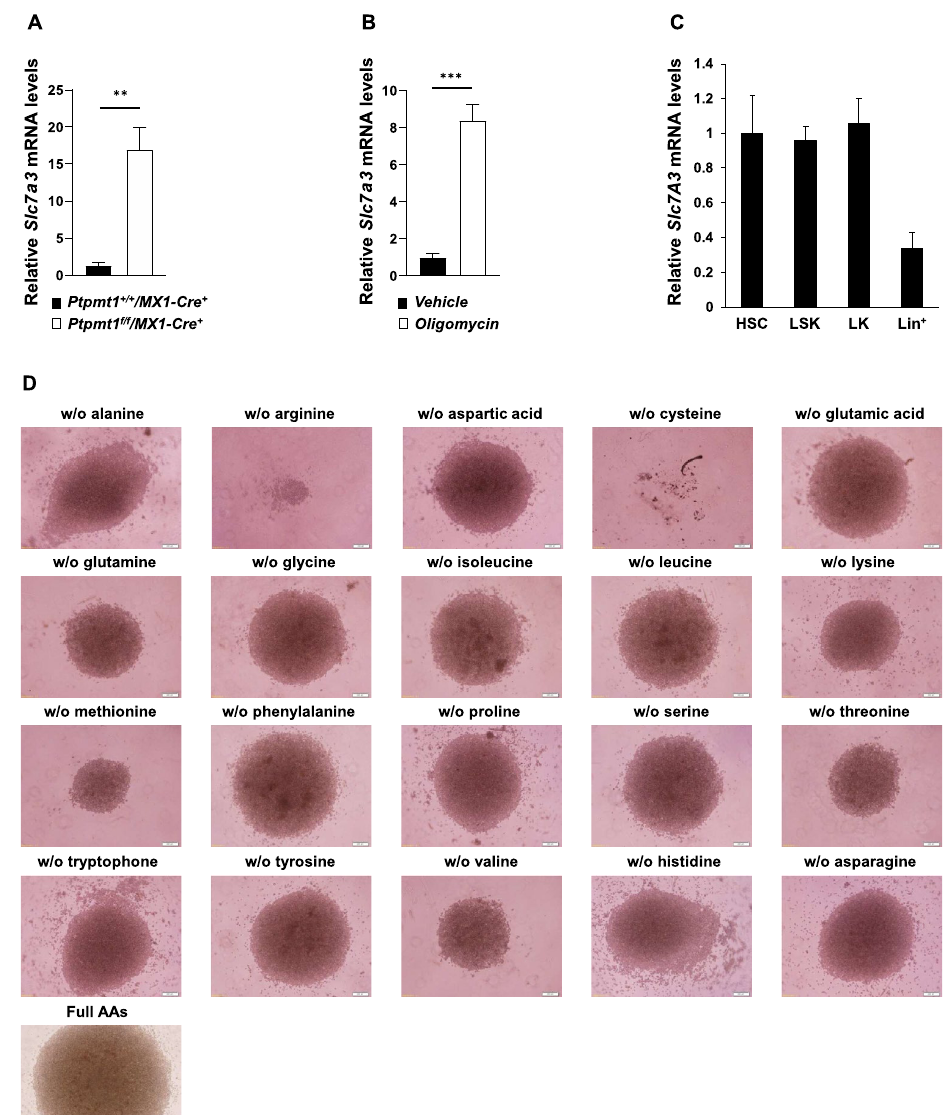
Figure 1. Slc7a3 is highly upregulated in response to defective mitochondrial metabolism, and exogenous arginine is required for the maintenance and/or function of HSCs. ( A ) LSK (Lin - Sca-1 + c-Kit + ) cells were sorted from the BM isolated from pI-pC-administered Ptpmt1 f/f /MX1-Cre + and Ptpmt1 + / + /MX1-Cre + mice (n = 3 mice/ group). Total RNA was extracted. Slc7a3 mRNA levels were determined by qRT-PCR. ( B ) Lin − cells purified from the BM cells isolated from WT C57BL/6 J mice (n = 3 mice/group) were treated with oligomycin (1 µM) or vehicle for 24 h. Slc7a3 mRNA levels were determined as above. ( C ) Total RNA was extracted from HSCs (Lin − Sca-1 + c-Kit + CD150 + CD48 − ), LSK (Lin − Sca-1 + c-Kit + ) cells, LK (Lin − Sca-1 - c-Kit + ) cells, and Lin + cells sorted from healthy WT C57BL/6 mice (n = 3 mice/genotype). Slc7a3 mRNA levels were determined by qRT-PCR. ( D ) LSK cells freshly sorted from WT C57BL/6 mice were cultured (500 cells/well) in Earle’s Balanced Salt Solution supplemented with 10% FBS, Minimum Essential Medium vitamins (1x), SCF (50 ng/ml), IL-3 (20 ng/ml), IL-6 (20 ng/ml), and a mixture of amino acids that lacked the indicated specific amino acid. Seven days later, cells in each well were